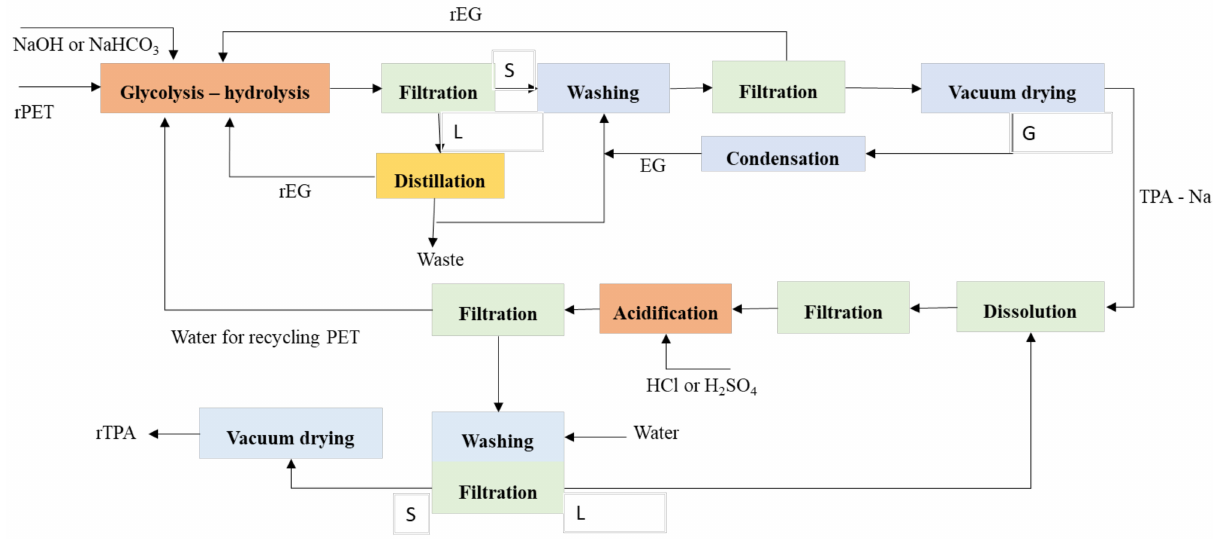
Figure 8. The possible reaction of PET by glycolysis–hydrolysis with the separation